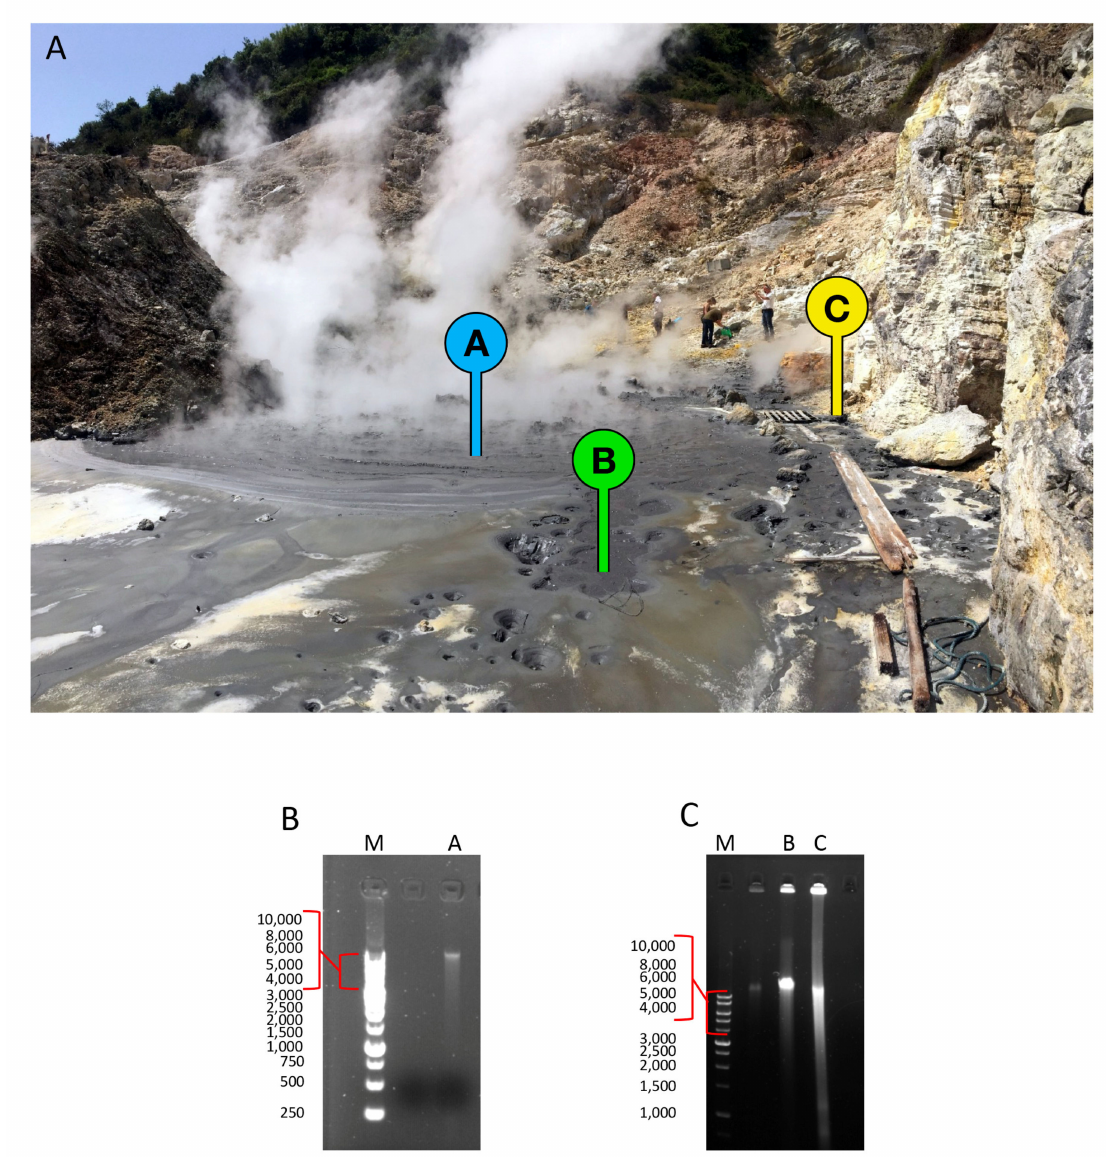
Figure 1. ( A ) View of the sampling site in July 2019. The sites A, B, and C are labeled by badges. ( B ) Agarose gel mDNA extraction from Site A. Lane M, Marker StoS 1Kb DNA Ladder (Genespin), lane A: mDNA from Site A. ( C ) Agarose gel of mDNA extractions from sites B and C. Lane M, Marker StoS 1Kb DNA Ladder (Genespin); lane B, mDNA from Site B; lane C, mDNA from Site